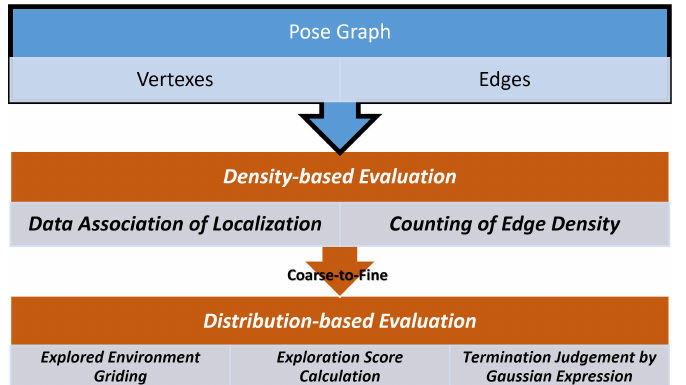
Figure 7. Organization of proposed termination condition, where the input is a built graph (including vertexes and edges), both density-based evaluation and distribution-based evaluation are contained in a coarse-to-fine